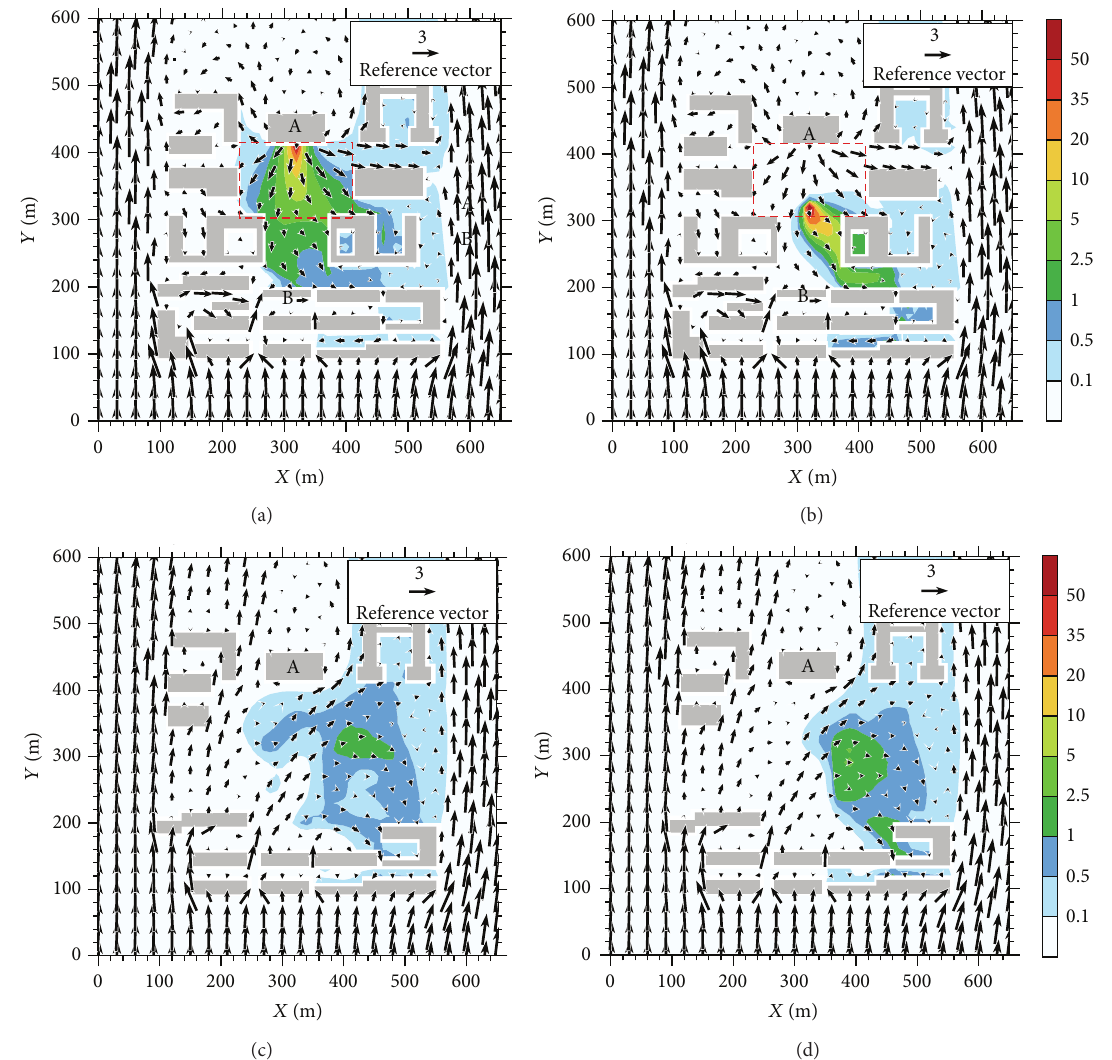
Figure 11: Simulated concentration (ppm) and wind vector fields at 2200 LST on 13th of August: (a, b) at 𝑧 = 2.5 m; (c, d) at 𝑧 = 22.5 m; (a, c) the point source was located at P1; (b, d) the point source was located at P2.